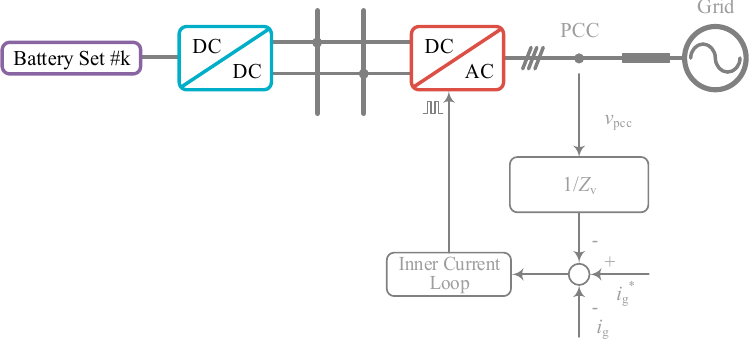
Figure 3. Control diagram of the power conditioning system (PCS).